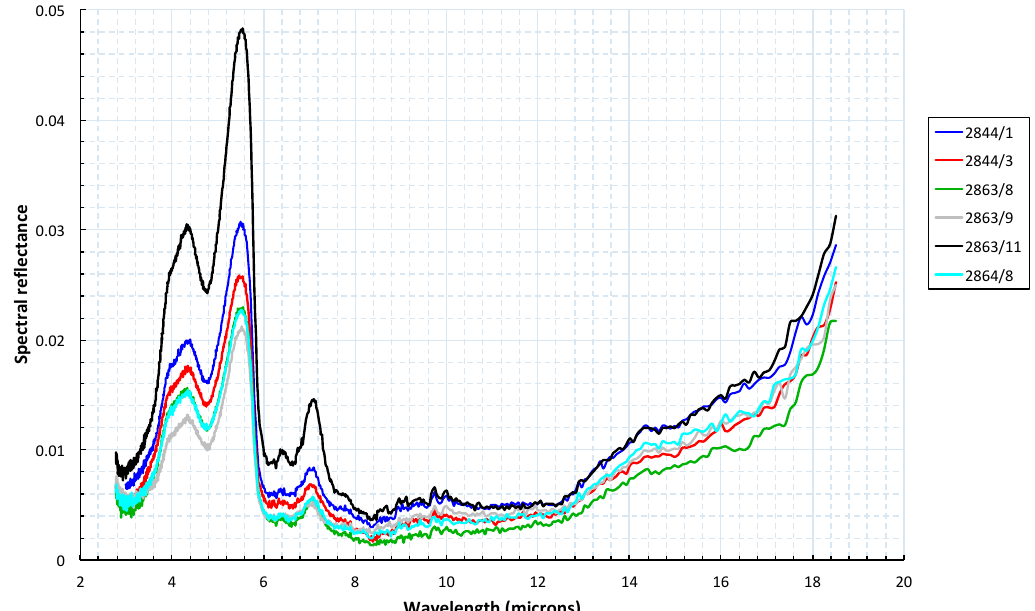
Figure 17. Spectral reflectance of the black-coating used for the SLSTR A and B BB cavities measured by NIST, and the resulting effective cavity emissivity from 2 to 20 µm [13]. At channel S7 (3.7 mm) the reflectivity of shows strong variation as a function of wavelength, but also from sample to sample suggesting a larger uncertainty of the cavity’s emissivity in this spectral channel.